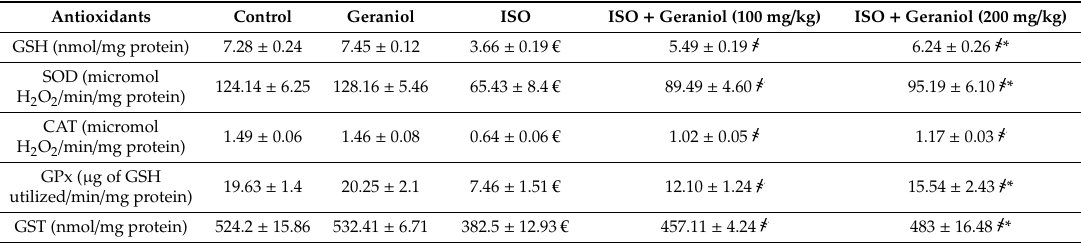
Table 2. The impact of geraniol pretreatment on ECG components in isoproterenol-induced myocardial infarction.